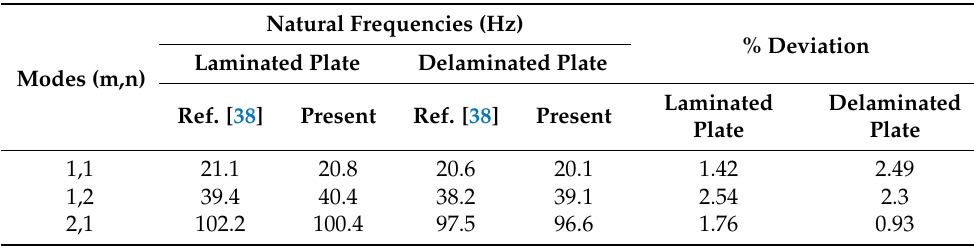
Table 2. Comparison of the natural frequencies of a tapered composite plate derived by utilizing the present FEM with those presented in [38].